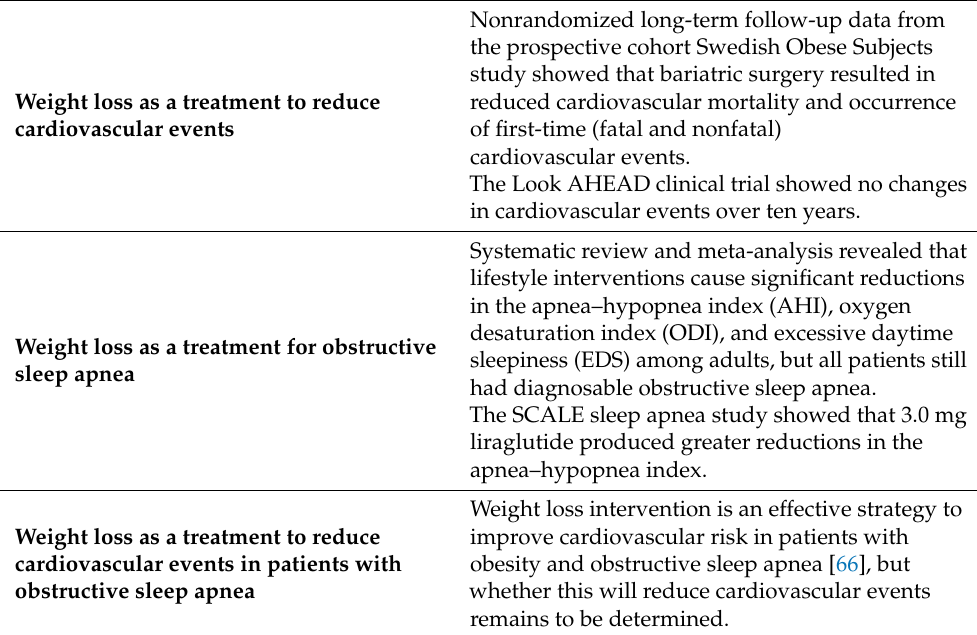
Table 2. Summary of weight loss as a treatment for cardiovascular events risk reduction, obstructive sleep apnea and to reduce cardiovascular events in patients with obstructive sleep apnea.